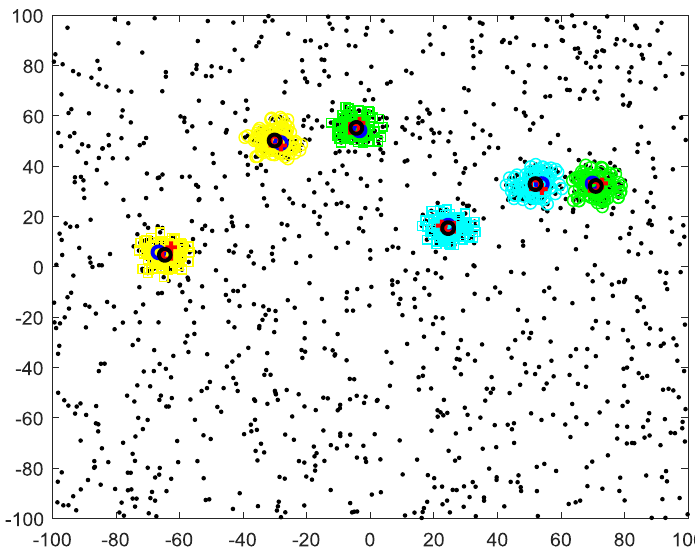
Figure 9. Mean estimated number of targets and mean OSPA of different algorithms over 20 MC trials.